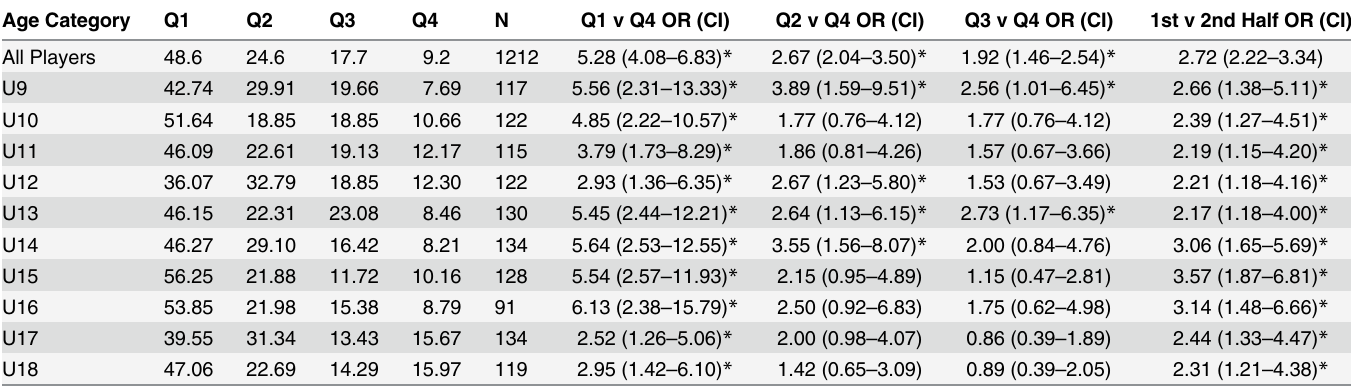
Table Notes: Q1 = % of N (total players in category) born between Sept-Nov of annual age cut-off dates, Q2 = Dec-Feb, Q3 = March-May, Q4 = June- August; 1 st Half = % of N born between Sept-Feb; 2 nd Half = Mar-August; OR = Odds Ratio calculation, (CI) = 95% Con fi dence Interval. * = Signi fi cant fi nding (cid:1)